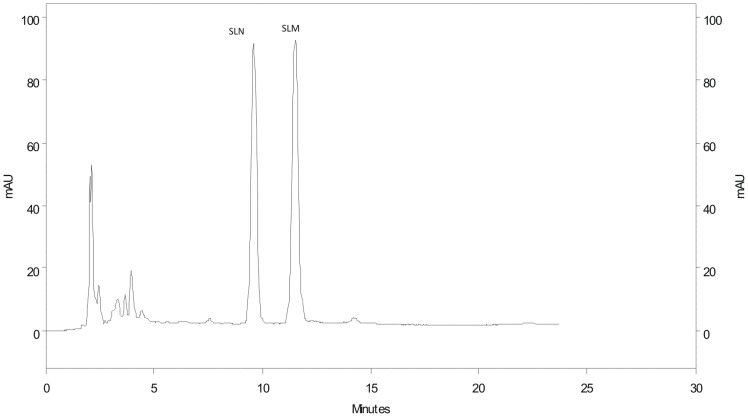
HPLC chromatogram of the alkaloidic extract of Solanum lycocarpum fruits.Zorbax-SB (5 µm), 250×4.6 mm column; mobile phase of acetonitrile and phosphate buffer 0.01 M (36.5∶63.5); flow rate of 1.0 mL/min and detection at 200 nm. SLN = Solasonine; SLM = Solamargine.